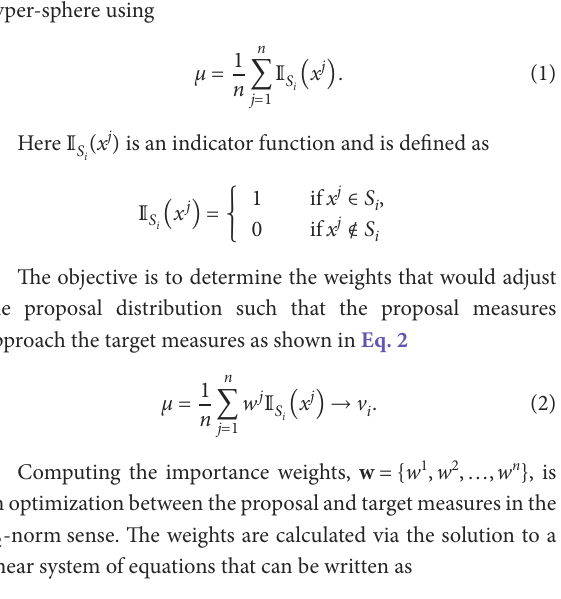
the total number of samples taken. Here we aim to determine the target distribution using target measures, v , obtained via model chain evaluations, and the random samples { x 1 , x 2 ,…, x n } obtained from the proposal distribution μ . In the present work, the proposal samples are generated using